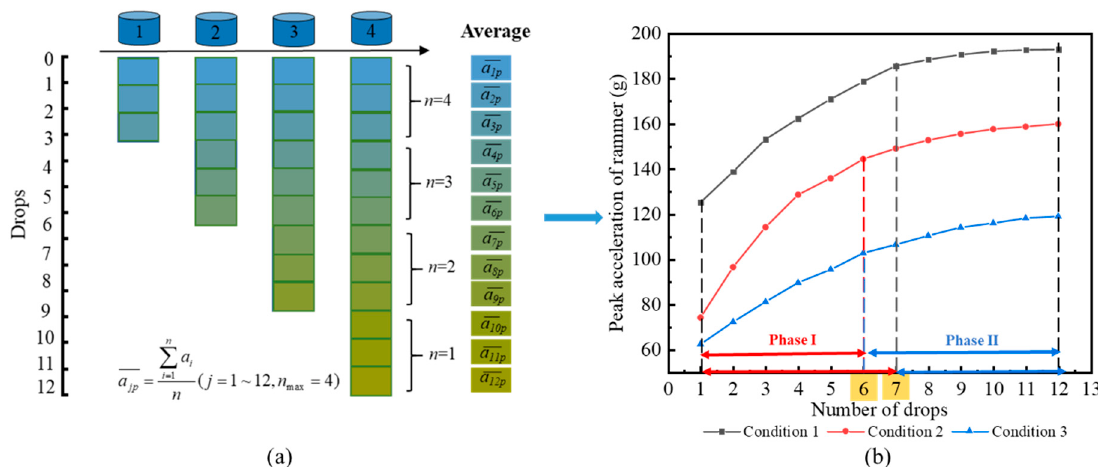
Figure 8. Analysis of peak acceleration of rammer: ( a ) average value of peak acceleration; ( b ) curve relationship between peak acceleration and dropping numbers of rammer.